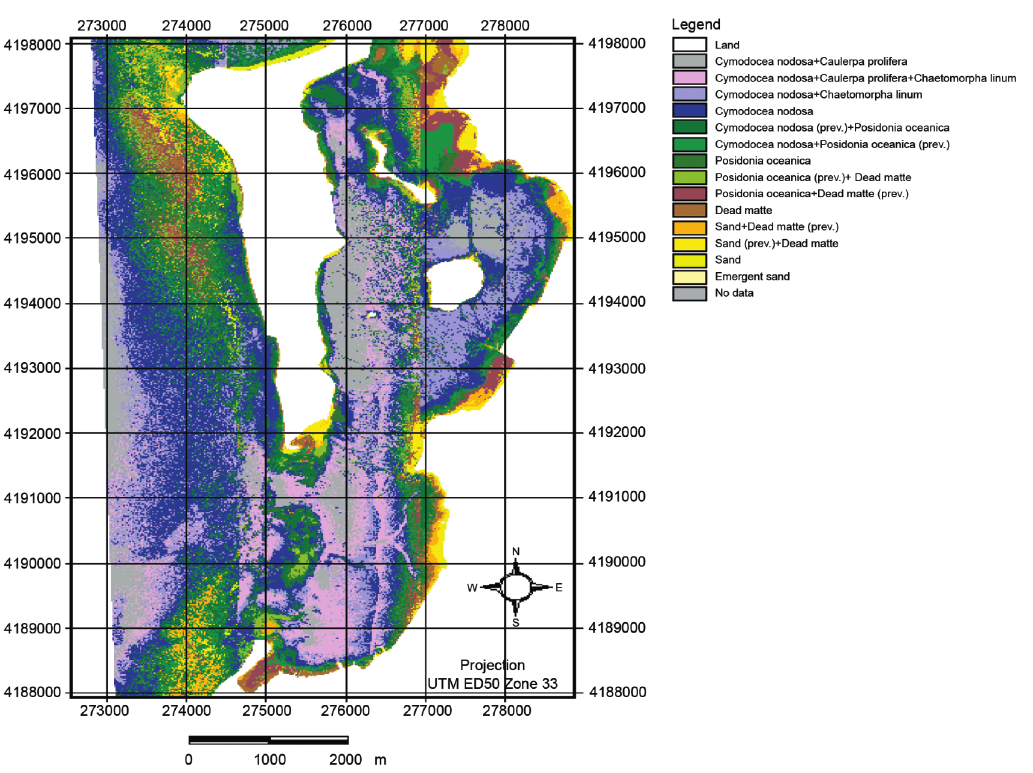
Fig. 2. Map of bottom